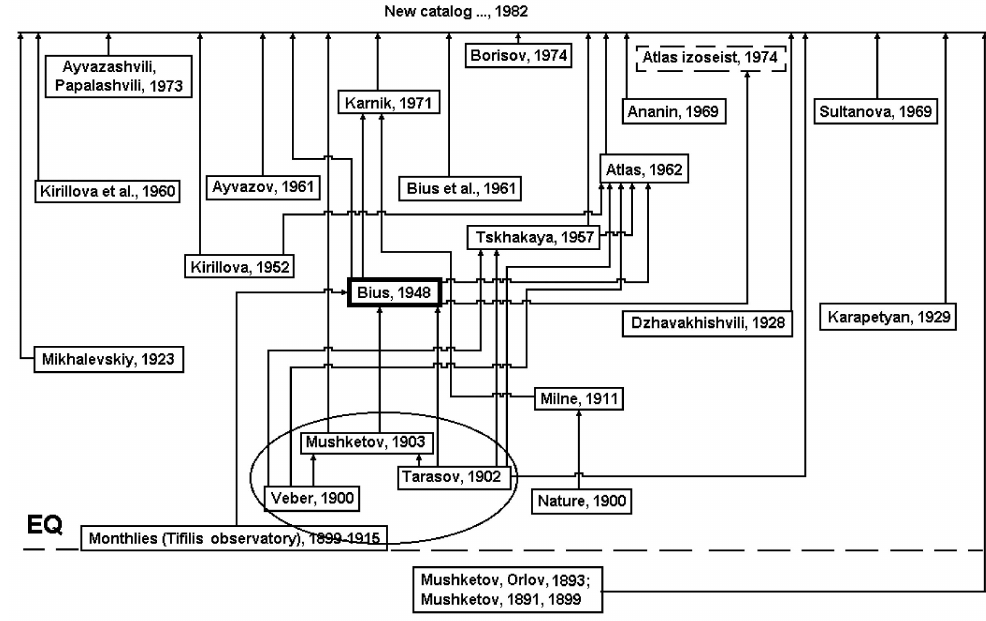
Fig. 6. Chronological scheme (reference-tree) of sources from Kondorskaya and Shebalin (1982) on 31 De- cember 1899, Akhalkalak earthquake compiled in Tatevossian et al. (1997). The catalogue of Bius (1948), which was the basic source for isoseismal map compilation, is shown in a bold rectangle; in a dashed rectangle is She- balin (1974), which is a ghost root for the catalogue entry; EQ indicates the earthquake origin time; in oval are enclosed sources, which represent primary